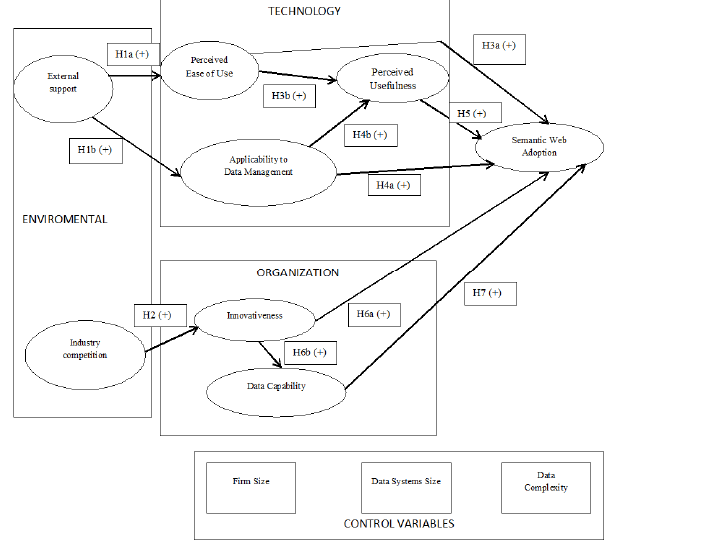
Fig. 2. Proposed Research Model for Semantic Web